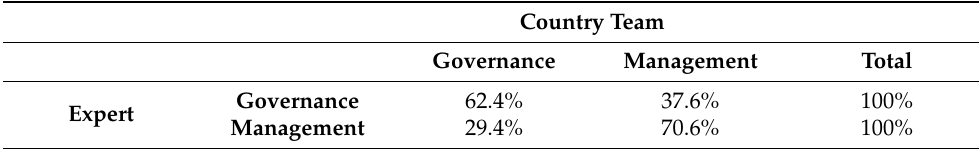
Table 1. Confusion matrix with country teams’ agreement with expert in Group